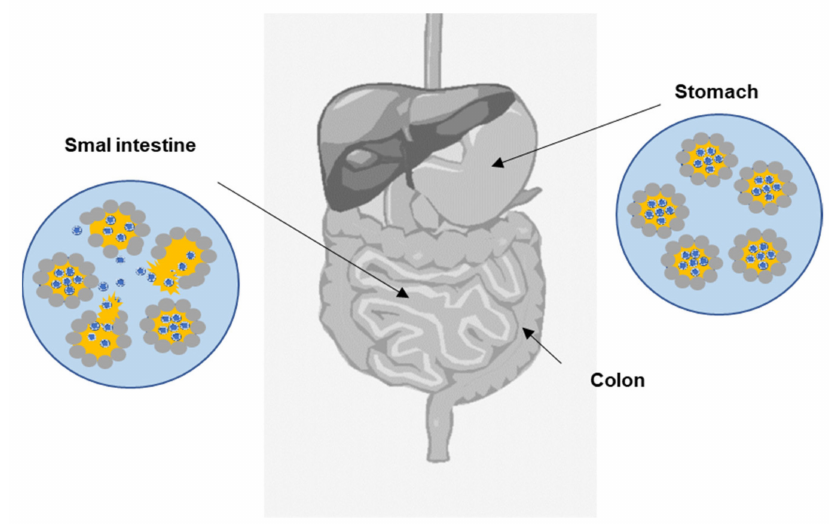
Figure 4. The scheme of the required behavior of w/o/w PMEs in gastrointestinal